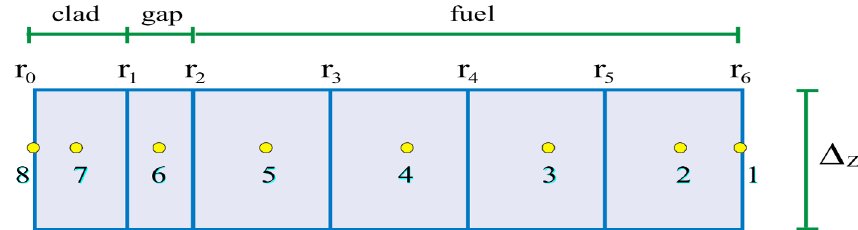
Fig. 7. Arrangement of the computational cells of fuel, gap, and clad.